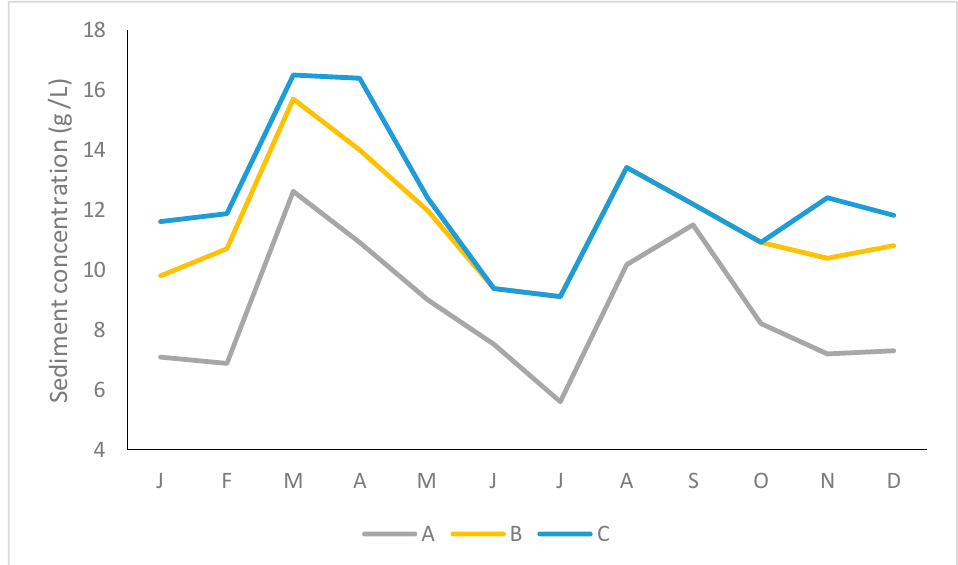
Figure 6. Temporal variability of sediment concentration. A: rural area, B: poor community, C: rich neighbourhood.